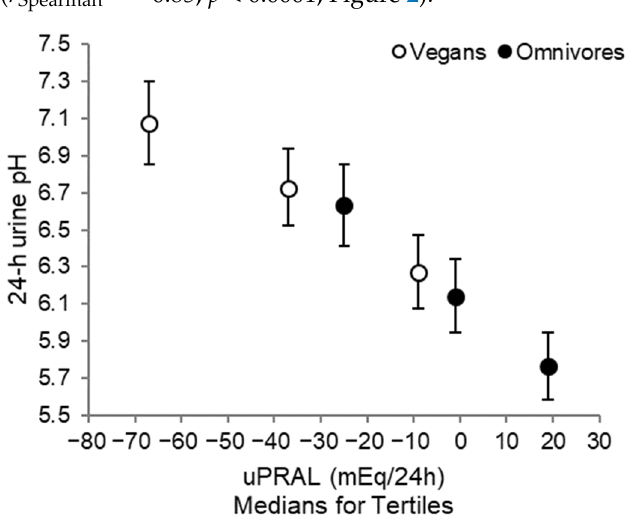
Figure 2. Geometric means and 95%-CI of 24 h urine pH in tertiles of uPRAL for vegans ( n = 34) and omnivores ( n = 35).